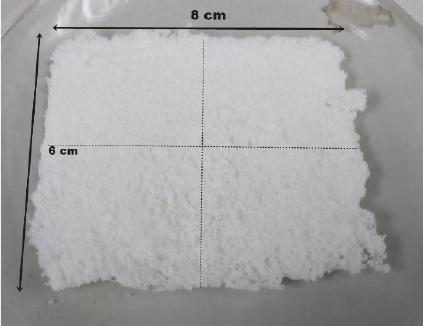
Figure 3: Naked porous 3D scaffold with an approximate size of 8cm × 6 cm × 1 cm (thickness) fabricated via solvent-casting particulate-leaching